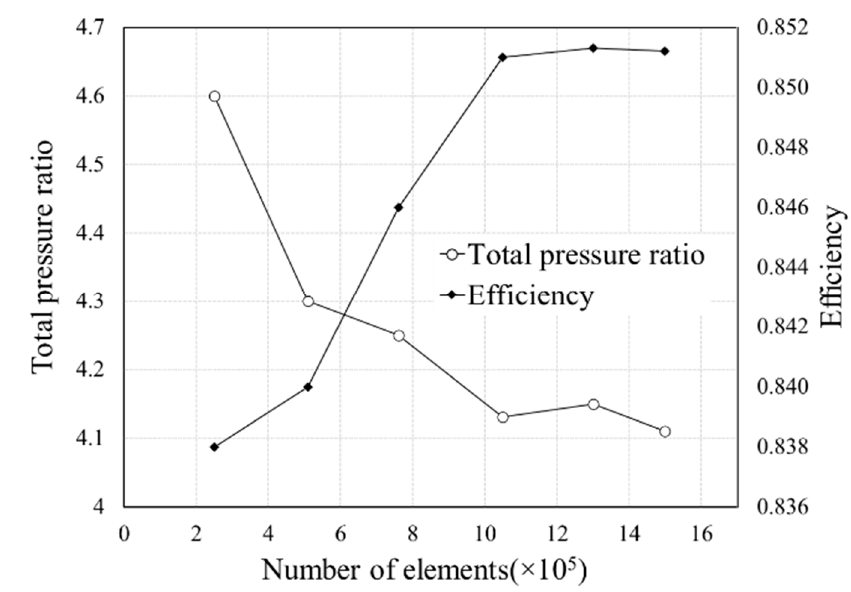
Figure 3. Performance results of the grid dependency test.